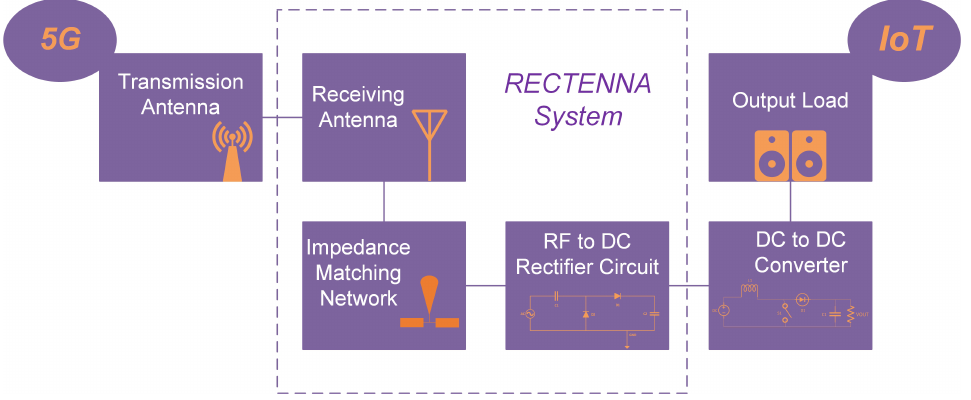
Figure 1. Complete RF energy harvesting